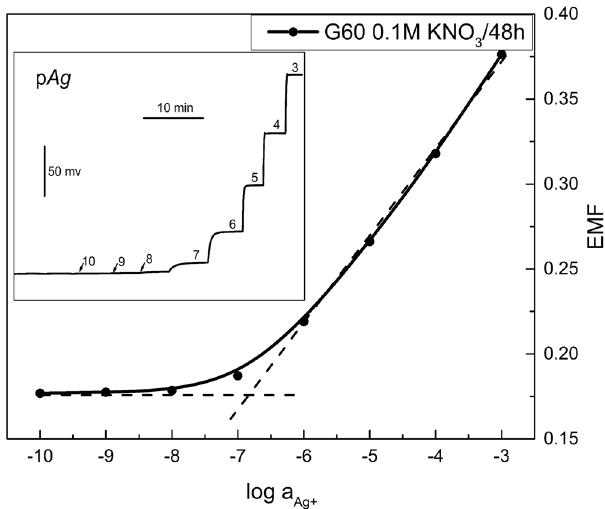
Figure 5. Calibration curve of G60 treated in 0.1 M KNO 3 electrolyte solution for 48